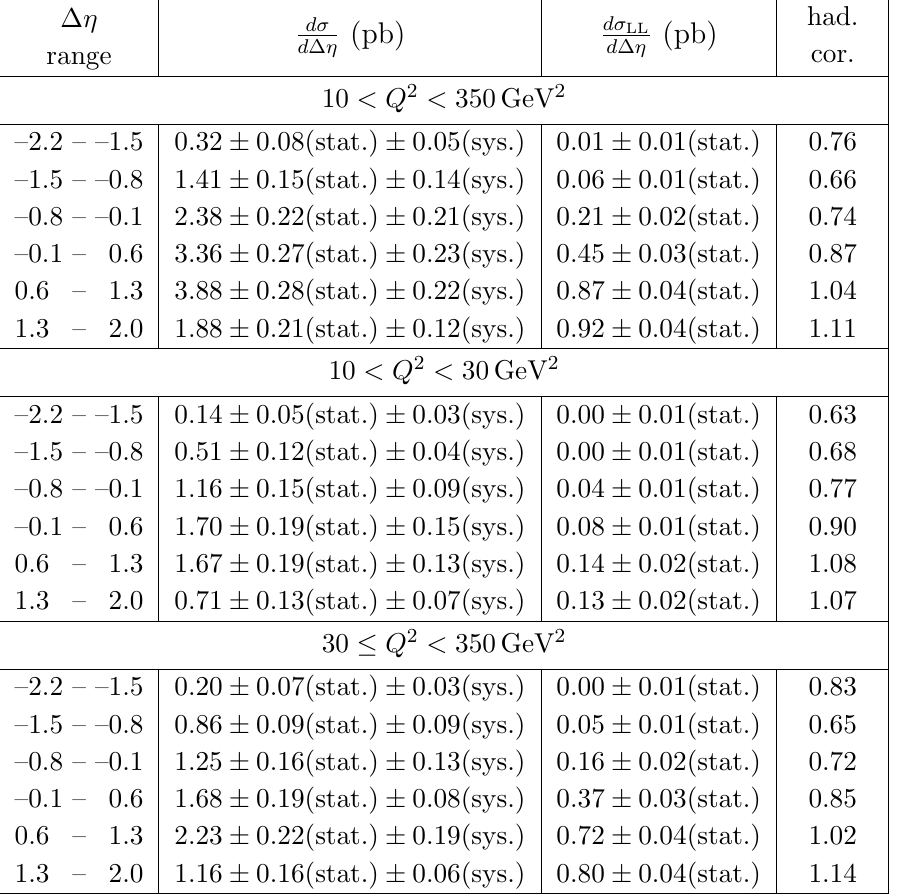
Table 4 . Measured di(cid:11)erential cross-section d(cid:27)